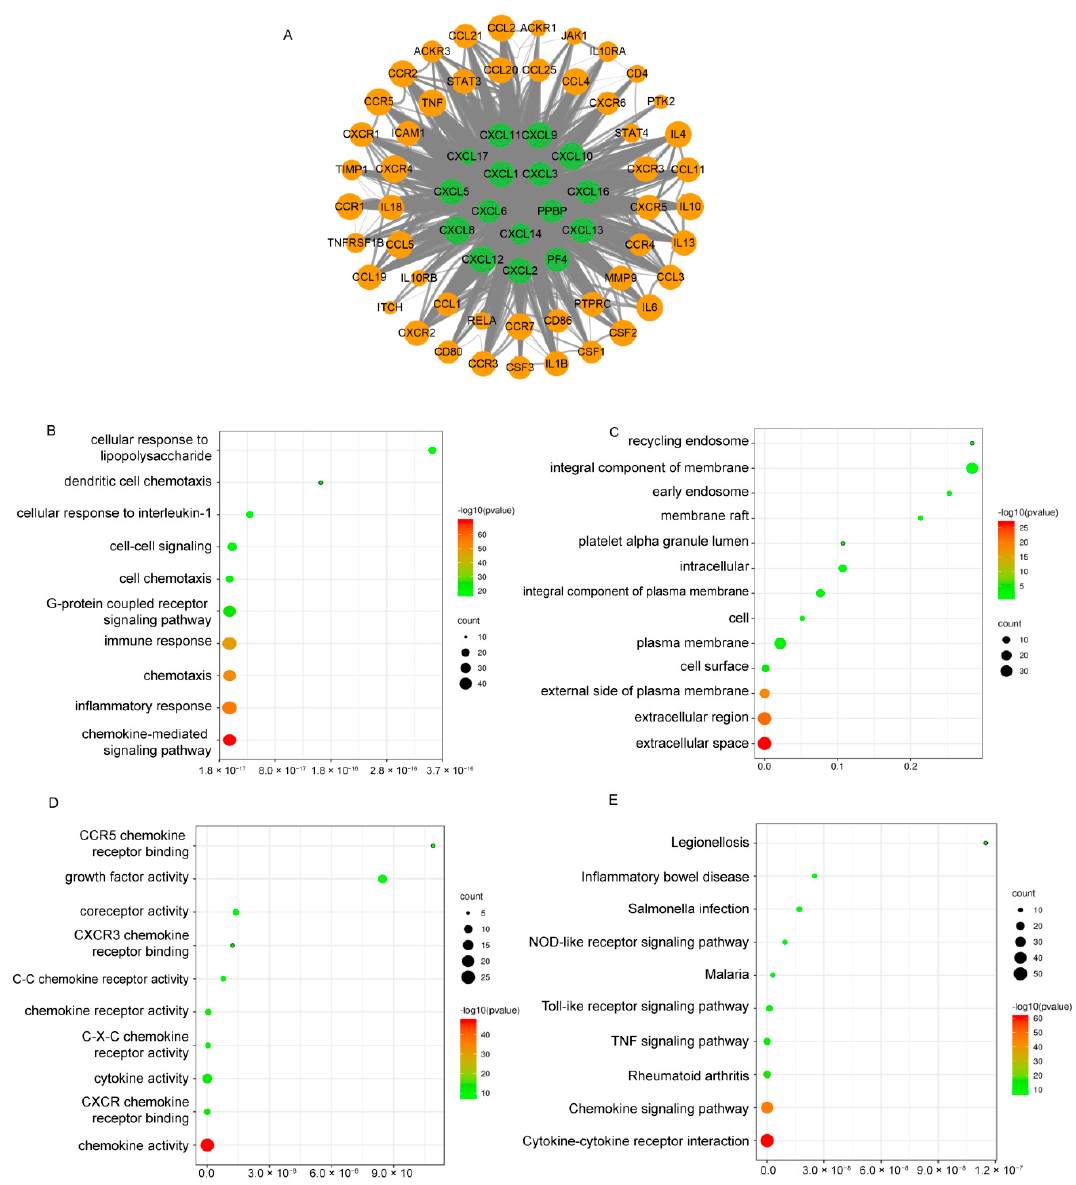
Figure 14. Predicted functions and pathways of CXCs and their 50 frequently interacting proteins in BRCA, COAD, and PDAC patients (String and DAVID). ( A ) Protein–protein interaction network of differentially expressed CXCs and 50 interacting proteins. ( B – D ) GO functional enrichment analysis predicted three main functions of CXCs and their 50 interacting proteins, namely, the biological process, cellular components, and molecular functions. ( E ) KEGG pathway analysis on CXCs and their 50 interacting proteins.